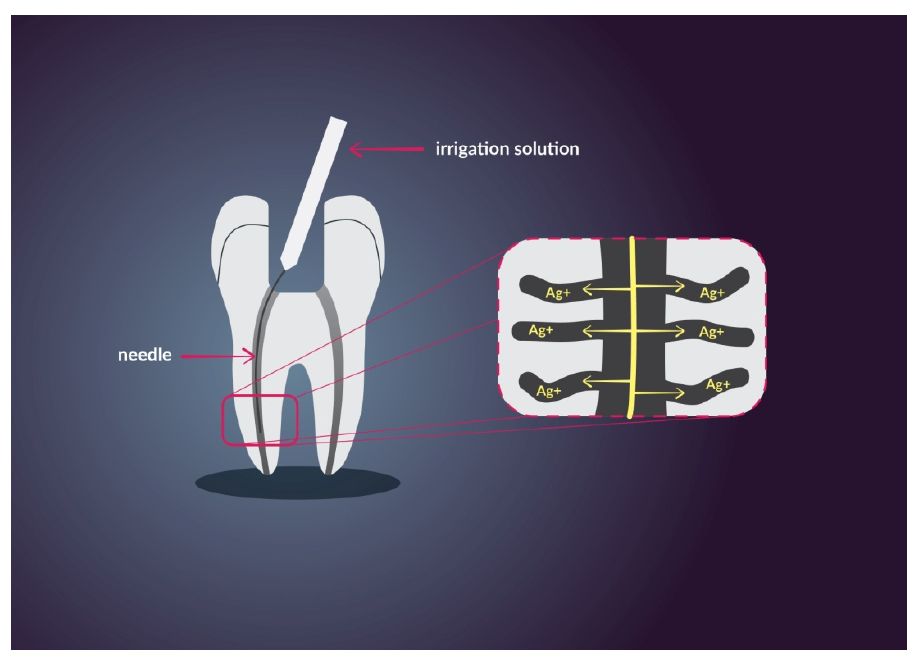
Figure 4. A scheme of irrigation with AgNPs solution. AgNPsreleaseAg + ions.